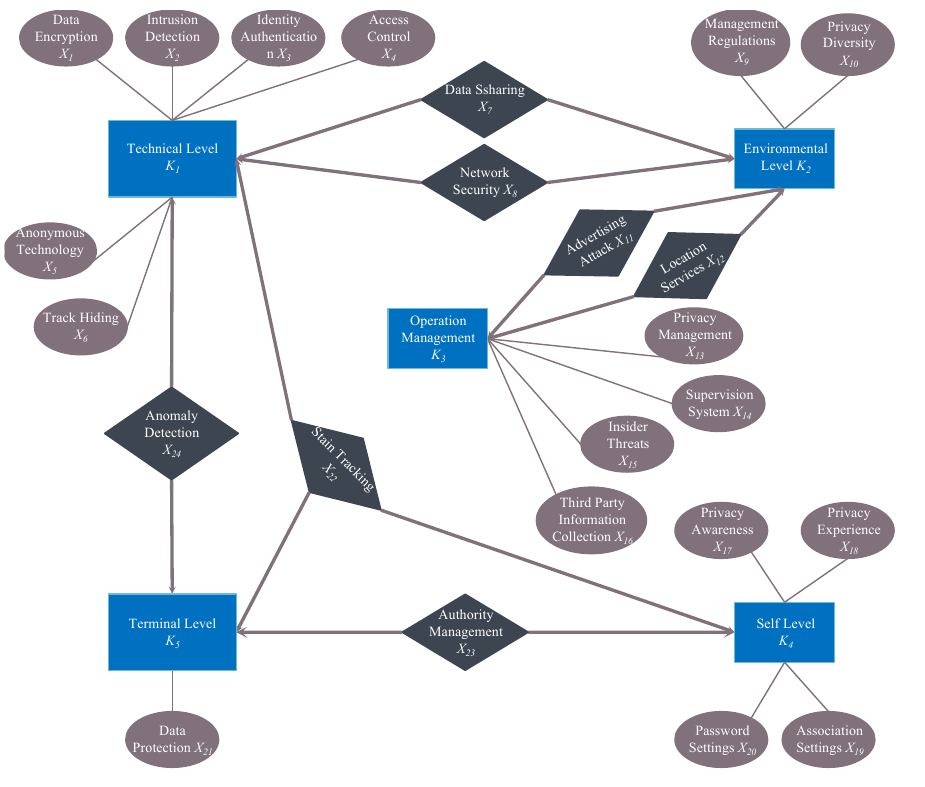
Figure 5. The evaluation index relation diagram.